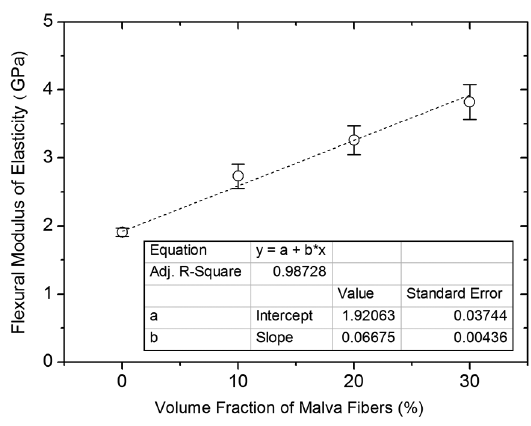
Figure 6. Variation of the flexural modulus with the volume fraction of malva fibers in epoxy composites.